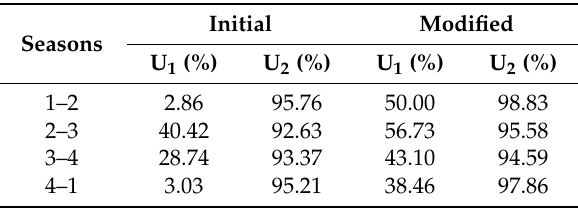
Table 6. Land cover change accuracies for different seasons.